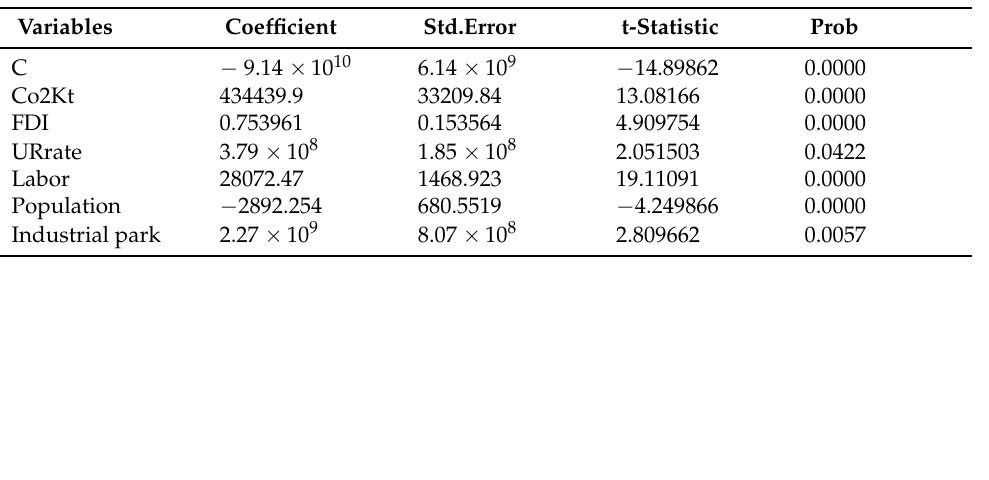
Table 5. Estimate the first model with fixed